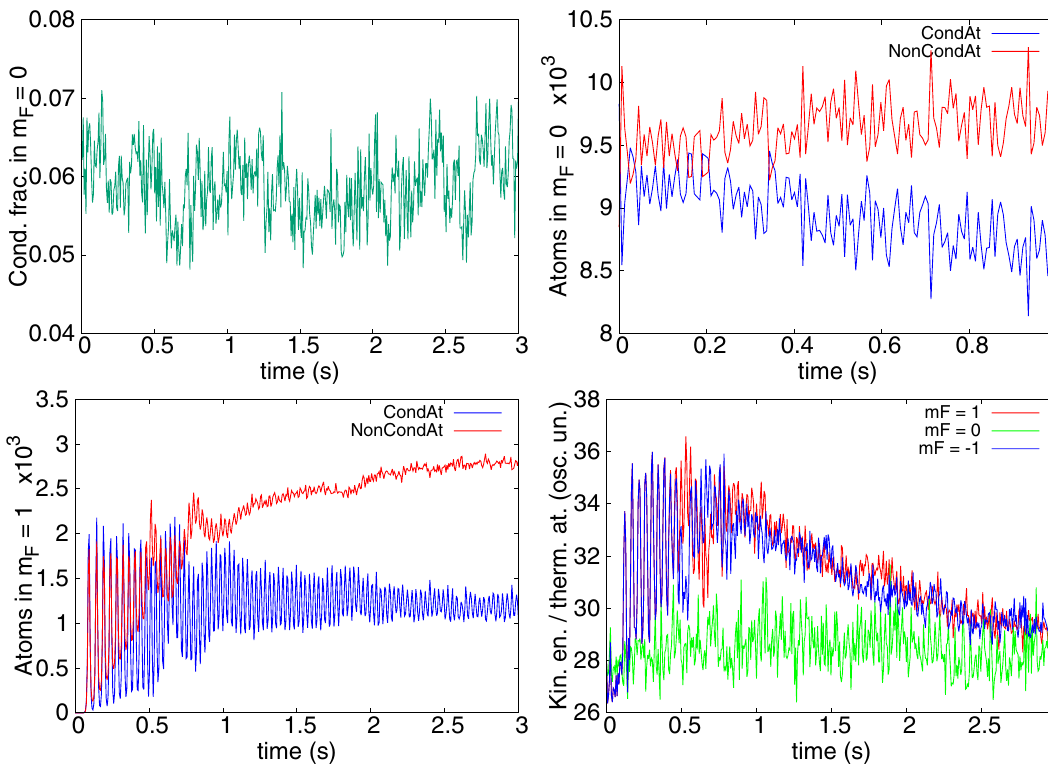
0 when starting Figure 9. Some investigations of sodium cooling. Top left: Condensate fraction in m F = 285 mG). Top right: condensate (blue) / thermal (red) 0.09 (cid:31) ω x (B from very low initial values (6%), q = = 0 when terms responsible for elastic ψ 0 & ψ populations in m F 1 ⇋ ψ 0 & ψ 1 collisions were removed = ± ± 100 mG). Bottom left: condensate/thermal populations in m F 0.011 (cid:31) ω x , B 1 for the q 0.09 (cid:31) ω x , 55% ( q = = = = initial codensate case shown in Fig. 6 (bottom left). Bottom right: Kinetic energy per thermal atom in the same 1, 0, 1 components, case, where red, green and blue lines correspond to the m F = −